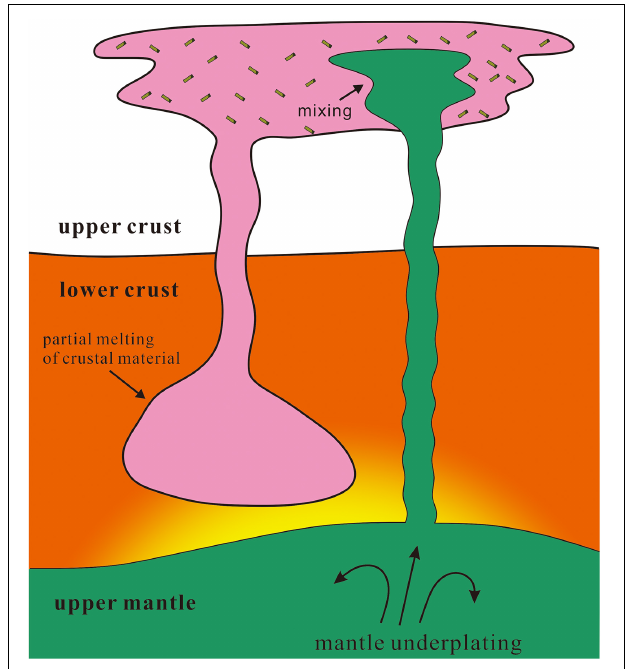
FIGURE 9 | Illustration of magma mixing during the formation of the Huangyangshan A-type granite and its MMEs (after Kemp et al., 2007).